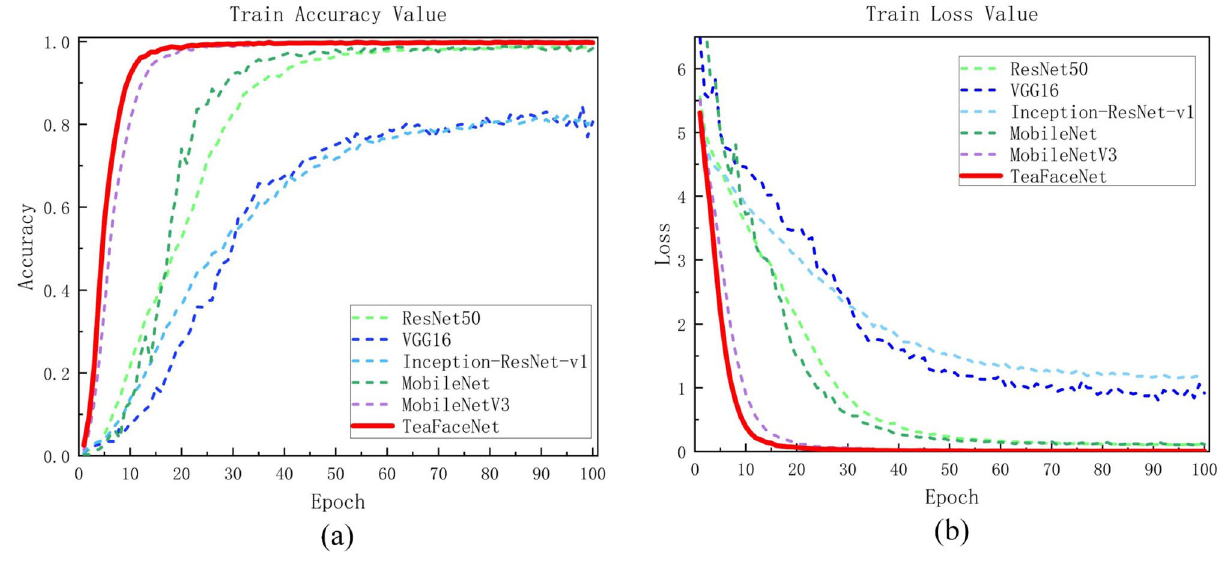
Figure 11. Loss and accuracy of raw tea dataset.